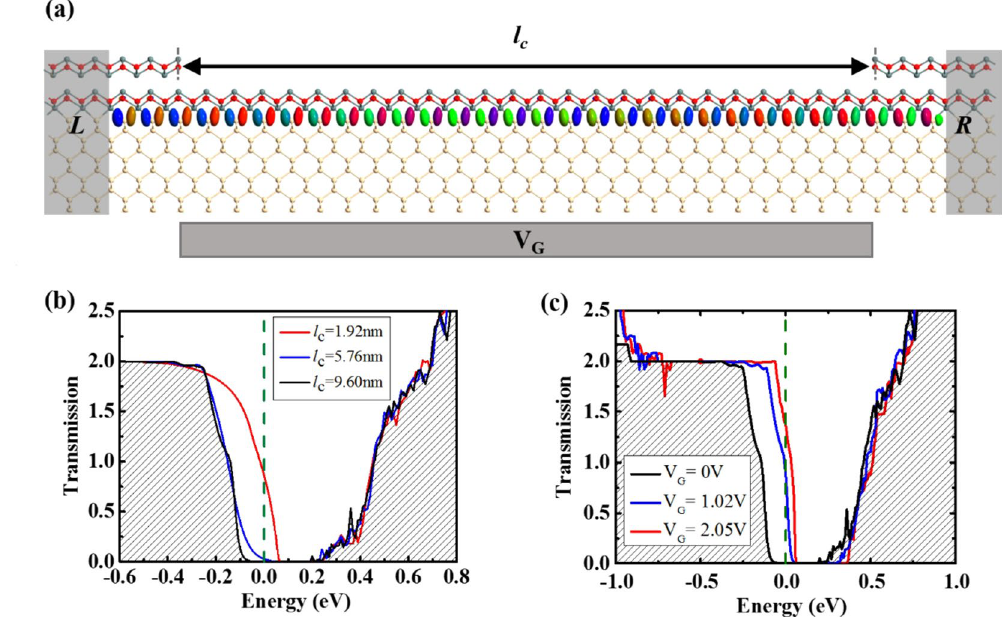
Figure 6. ( a ) Schematic representation of a BL/ML/BL SnO/Si(001) FET with transmission along x:[110] direction. The BL/ML/BL corresponds to the left electrode (L)/channel region (C)/right electrode (R). l c corresponds to the channel length. Yellow: silicon, red: oxygen and grey: tin. Transmission eigenstate at Fermi level (V G = 1.02 V) is also shown. ( b ) Transmission spectrum with respect to the central length l c . ( c ) Transmission spectrum with l c = 9.60 nm under different gate